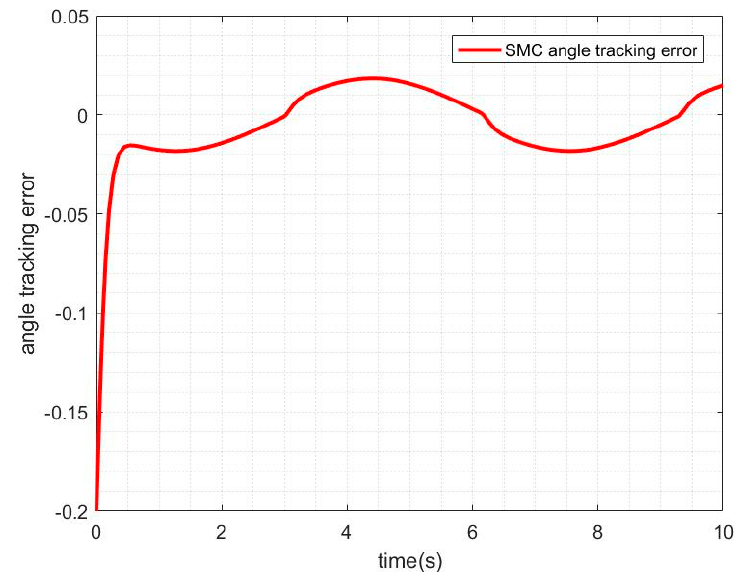
Figure 5. SMC angle-tracking error without friction Figure 5. SMC angle − tracking error without friction disturbance.